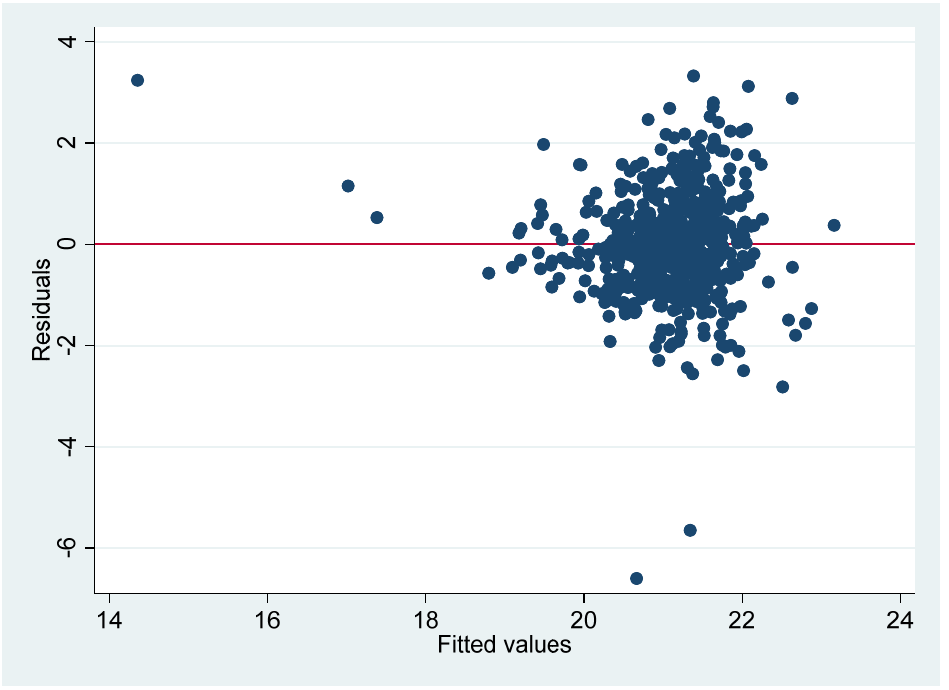
Figure 1. Firm performance varies across industries. The Y axis in the graph plots residuals obtained by regressing firm performance with variables in the right-hand side. The X axis plots firm performance (net income per employee).